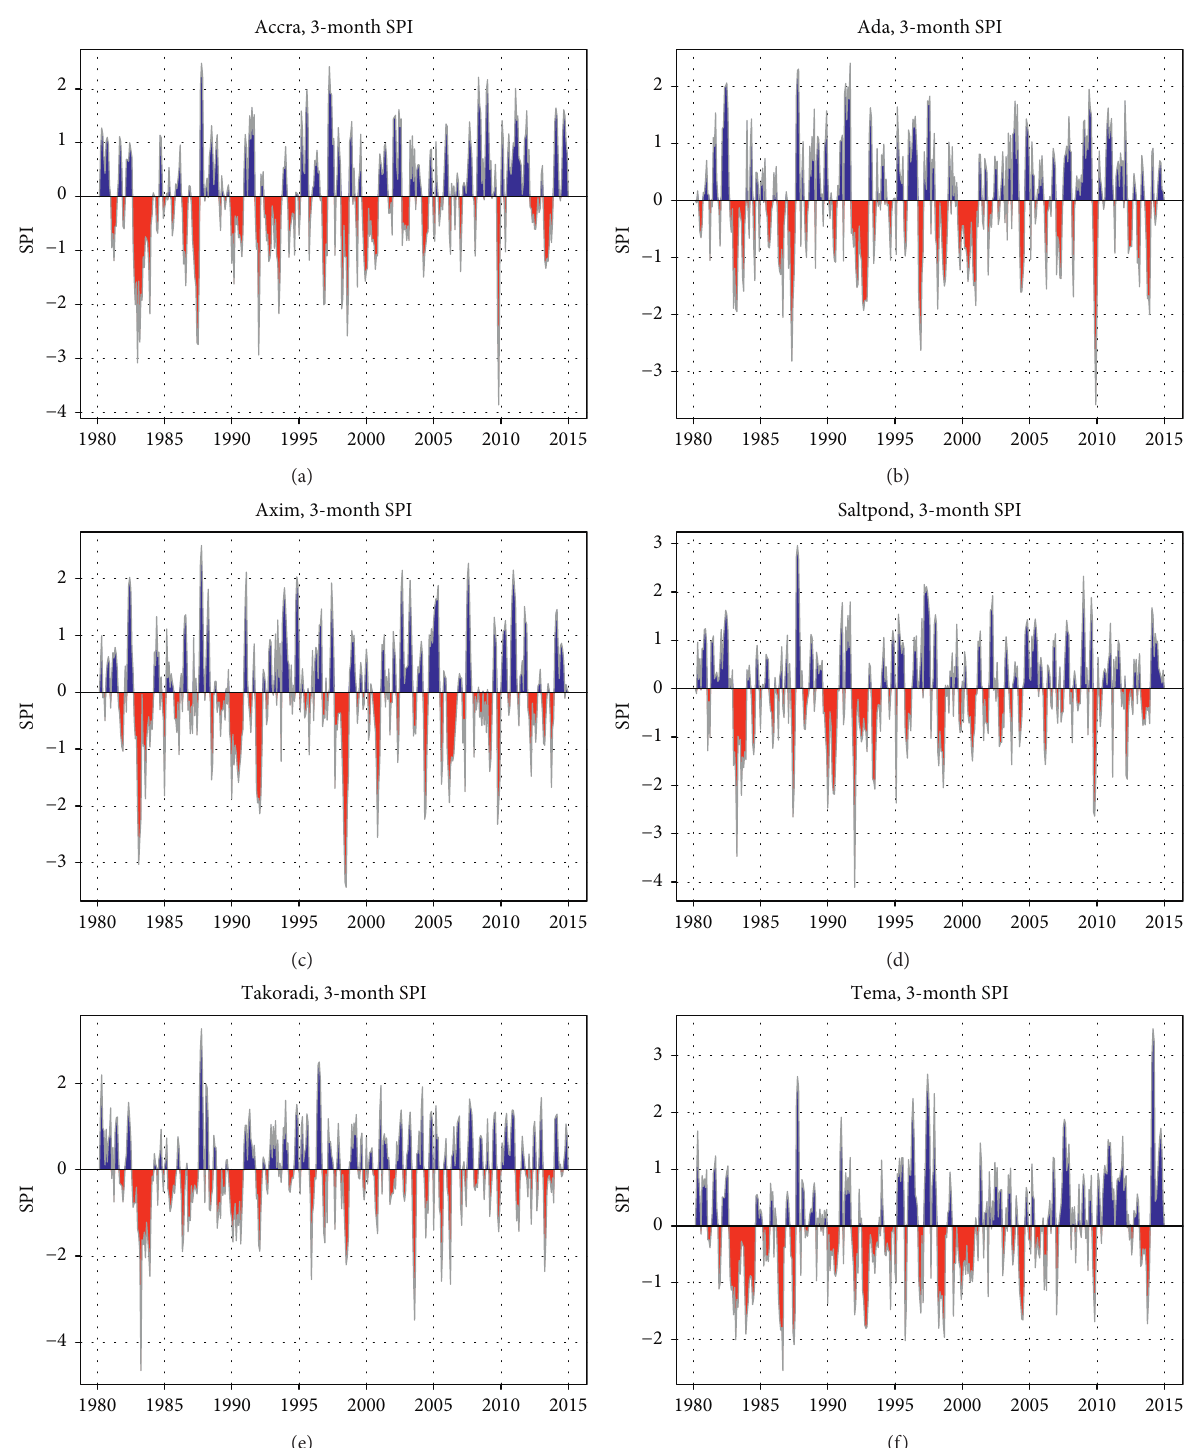
Figure 3: Three months’ SPI of six synoptic coastal meteorological stations in Ghana from 1984 to